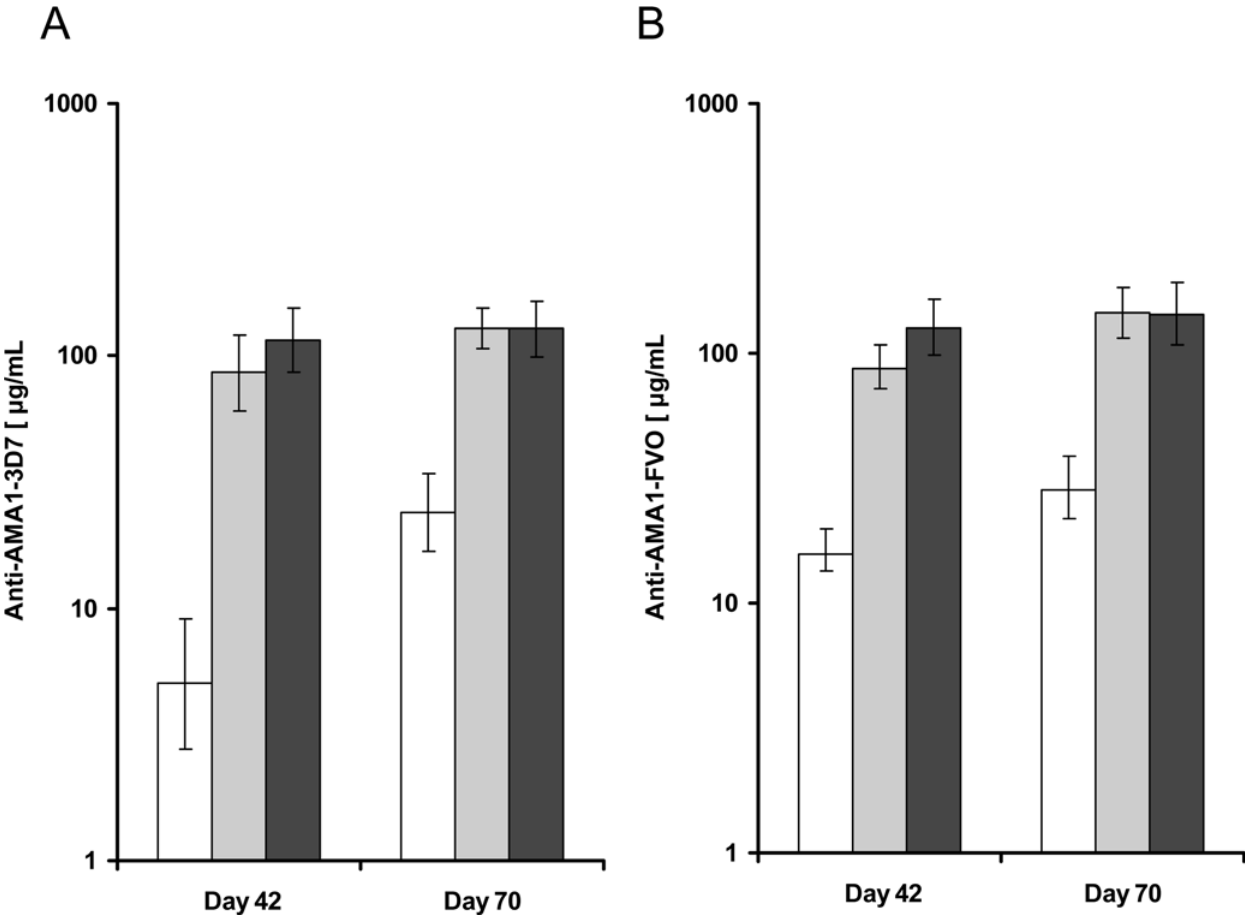
Figure 2. Anti-AMA1 antibody responses: Day 42 and 70 AMA1 antibody responses in recipients of the 20 or 80 m g AMA1-C1/ Alhydrogel 6 CPG 7909 vaccines. Antibody responses against AMA1-3D7 (A) and AMA1-FVO (B) measured by ELISA in sera collected on Day 42 (14 days postvaccination 2) and Day 70 (14 days postvaccination 3). ELISA results are shown as the geometric mean of AMA1-specific antibody ( m g/ mL) with standard error. The bars represents 80 m g AMA1 (white bar, n =25), 20 m g AMA1 + CPG (grey bar, n =12), and 80 m g AMA1 + CPG (black bar, n =29).